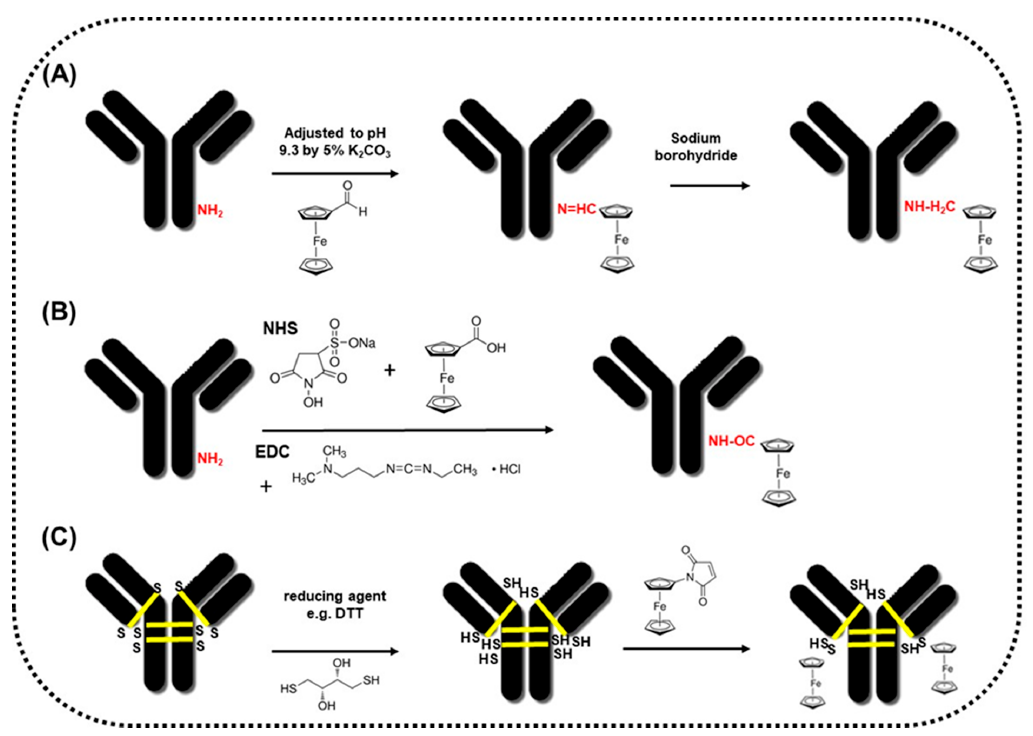
Figure 2. Schematic representation of procedures for antibody labelling with ( A ) ferrocenecarboaldehyde, ( B ) ferrocenemonocarboxylic acid, ( C ) ferrocenemaleimide.